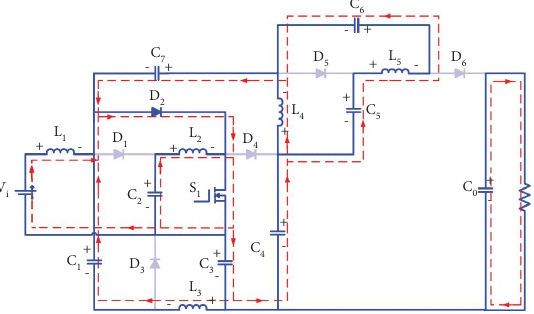
Figure 2: Equivalent circuit of proposed in mode-I.